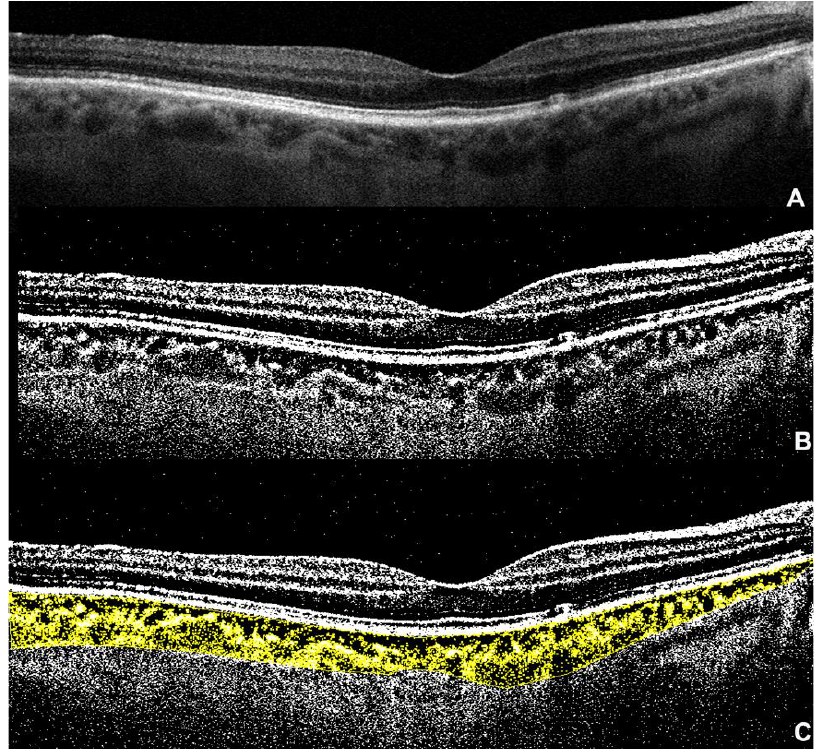
Figure 2. Choroidal vascularity index (CVI): ( A ) spectral-domain optical coherence tomography (SD-OCT) subfoveal B-scan; ( B ) the same image after binarization using Niblack’s autolocal threshold technique; ( C ) the binarized image after applying color threshold into a polygonal selection traced between the retinal pigment epithelium and the choroid–scleral junction; the dark pixels represent the luminal areas, while the remaining light pixels represent the stroma.